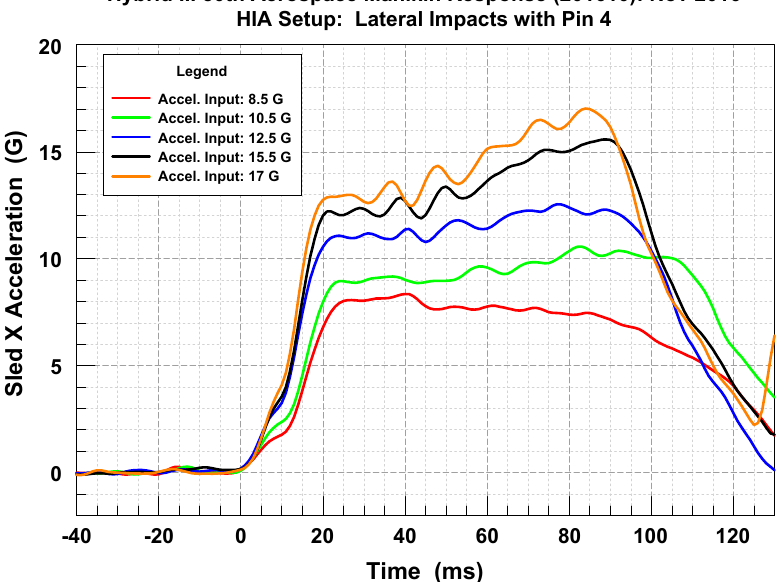
Figure 3. HIA sled pulses used for ATD impacts. The graph presents time history examples of the acceleration profiles used for each impact level with 8.5 G profile at the bottom progressively increasing to the 17 G profile at the top.